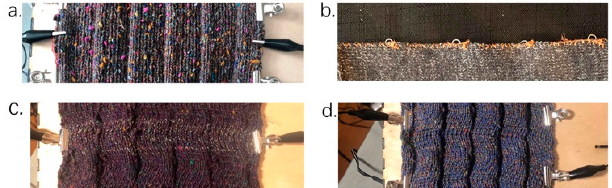
Figure 5. Connections: Leads with ( a ) crocodile clips, ( b ) stitches, ( c ) clips, ( d ) clips at different